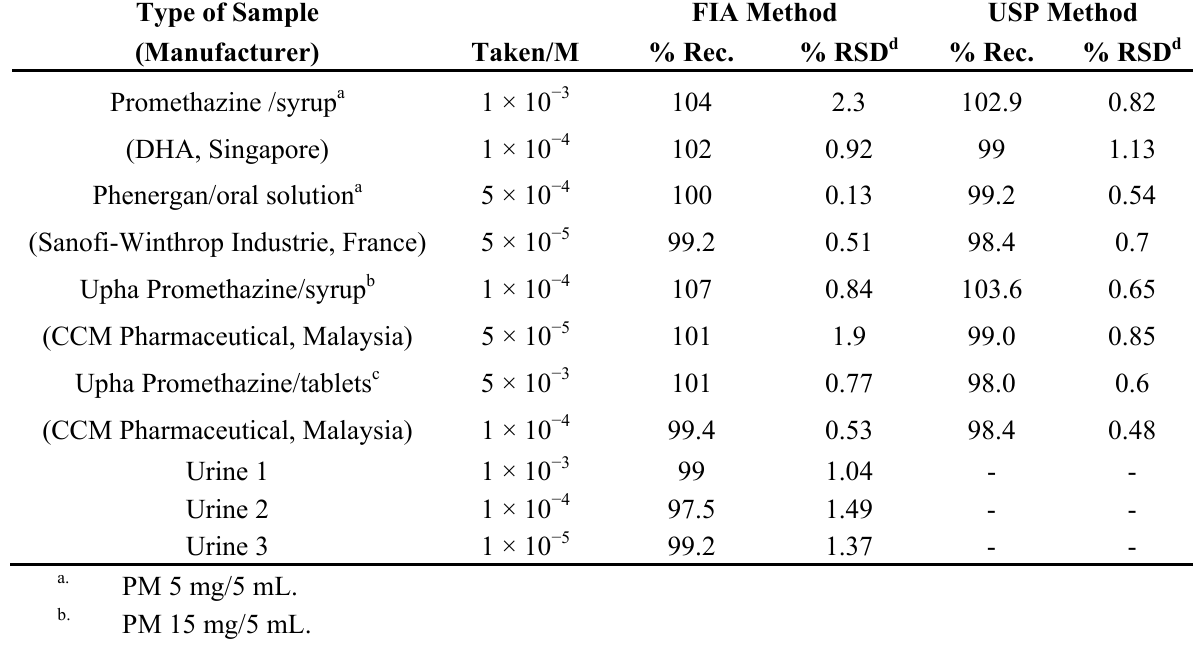
Table 3. FIA determination of promethazine in syrups, tablets and spiked urine samples using sensor